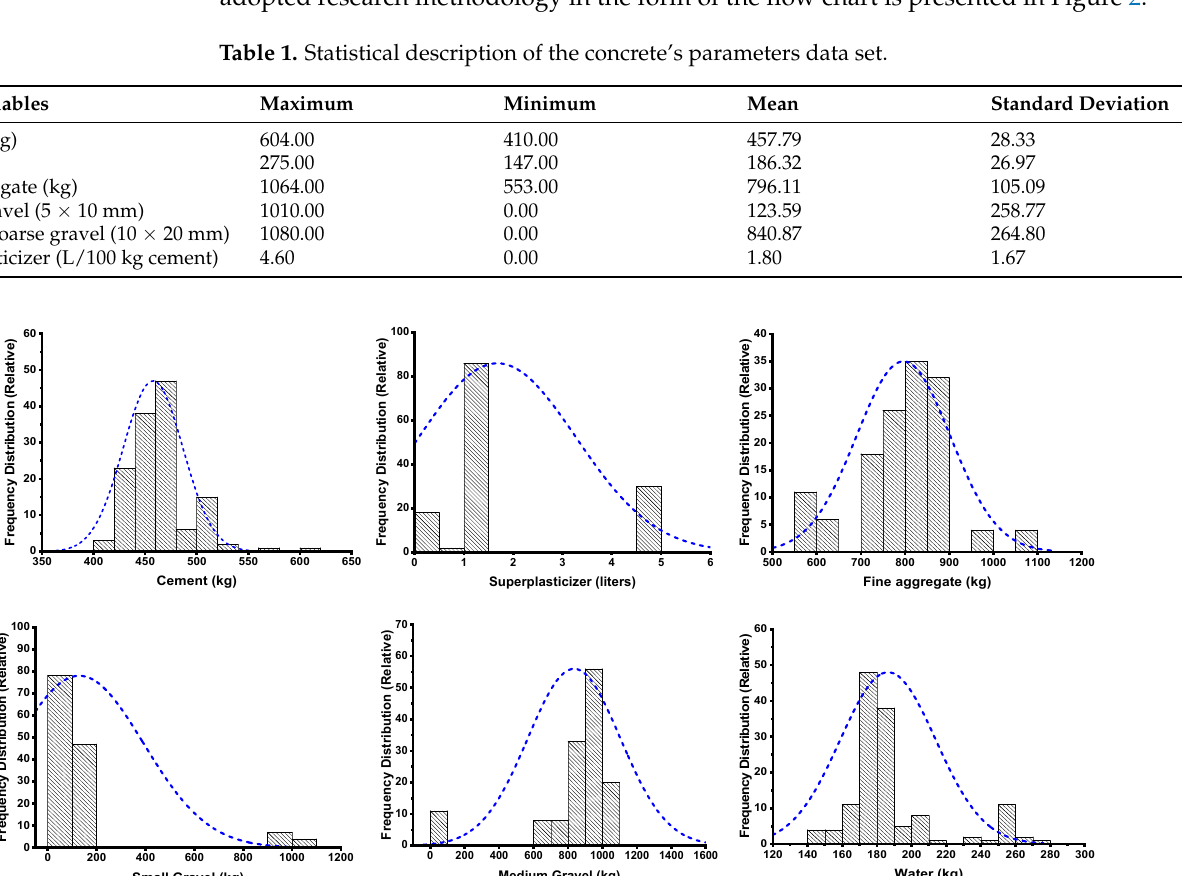
Figure 1. Graphical representation of relative frequency distribution for input parameters.